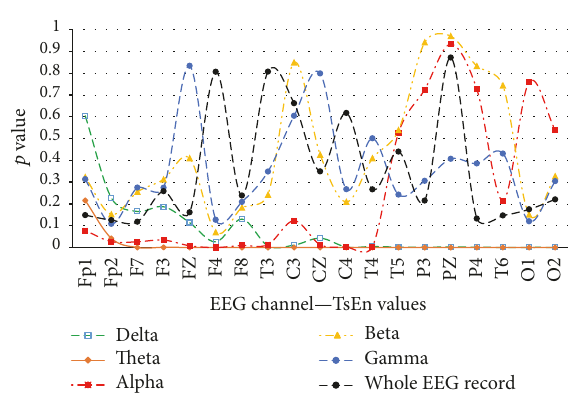
Figure 5: 𝑝 values for TsEn between AD patients and normal subjects of the training EEG dataset.